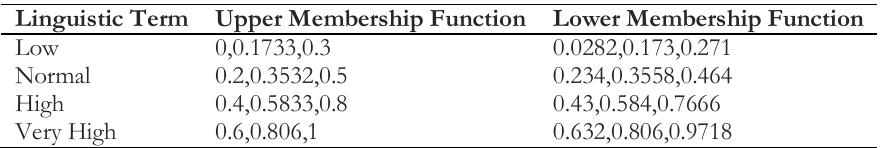
Table 3. Membership function values for Shock Prediction.